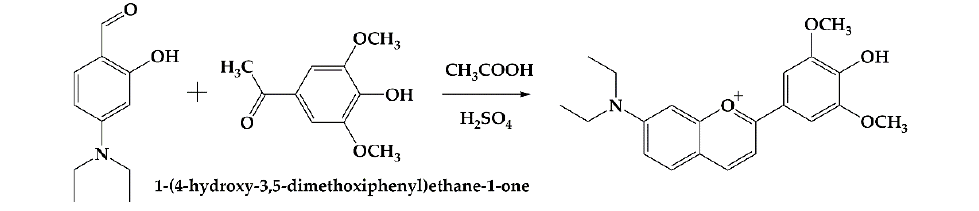
Figure 1. Reaction scheme for the synthesis of the flavylium